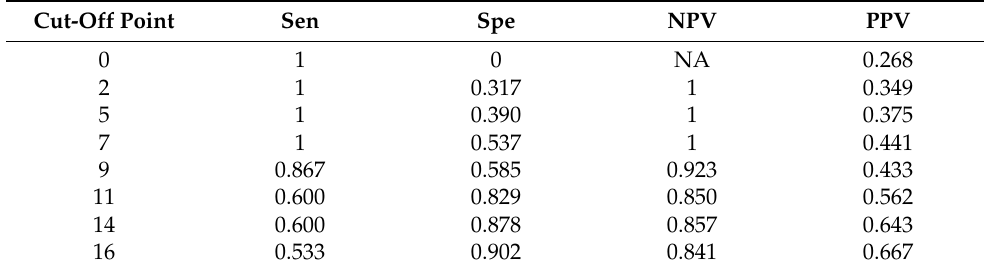
Table 4. ROC curve result for the HAG index.